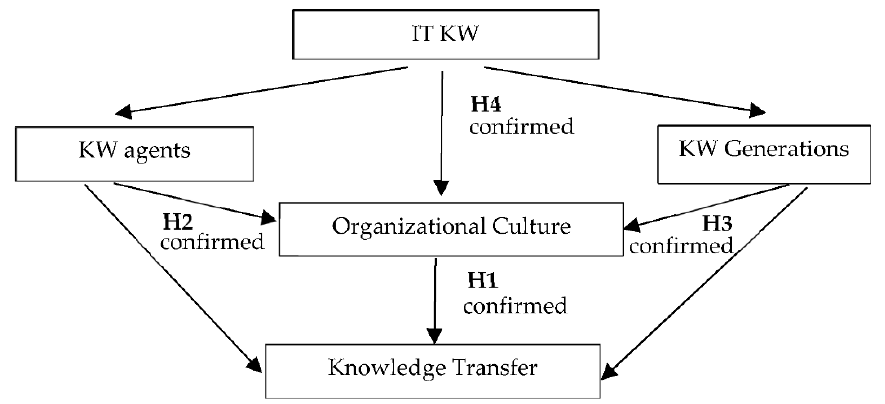
Figure 2. Verification of research hypotheses.